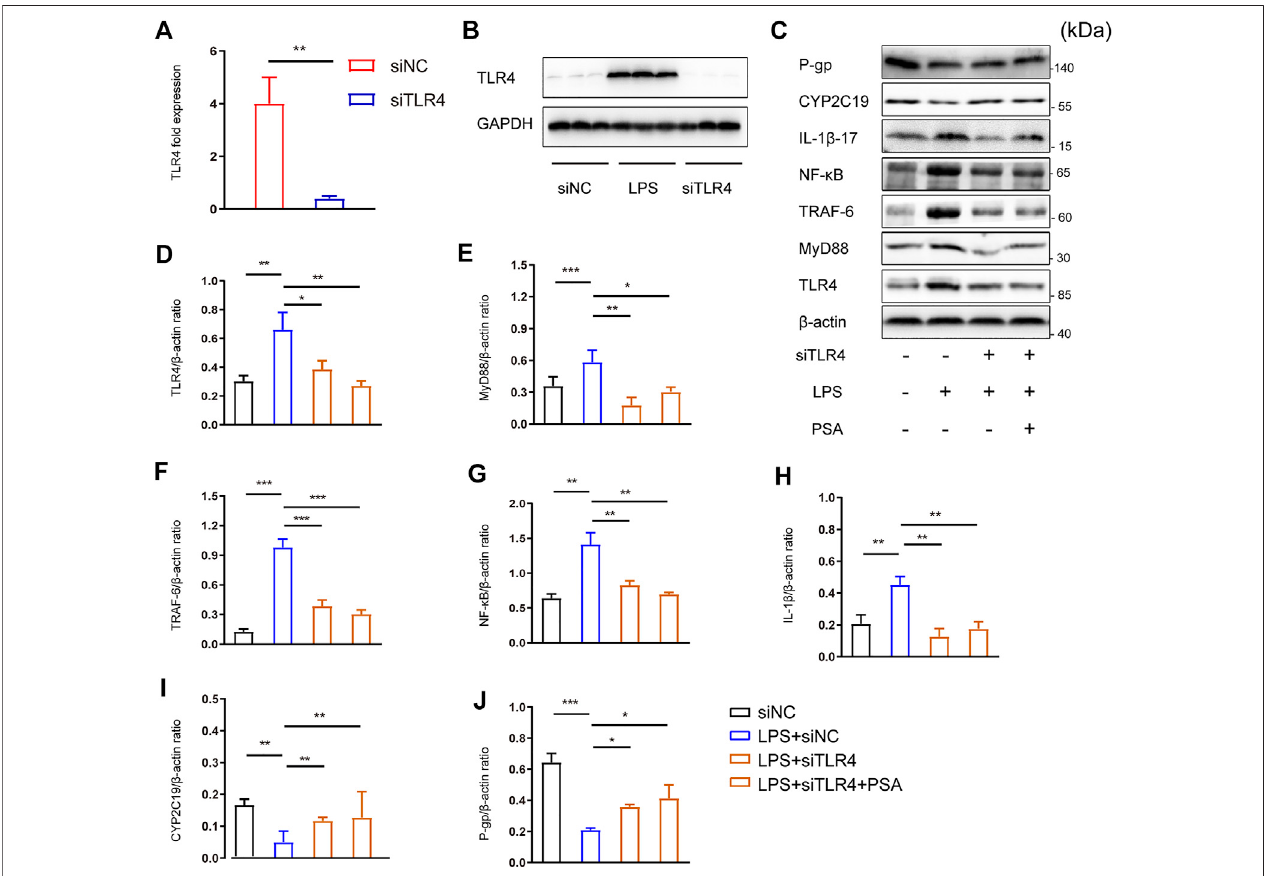
FIGURE 7 | PSA up-regulates the expression of hepatic CYP2C19 and P-gp by inhibiting TLR4/NF- κ B signal pathway. (A,B) RT-PCR and Western blot analyses were used to evaluate the ef fi ciency of TLR4 knock-down by siRNA (** p < 0.01) (C – H) Immunblots (C) and densitometric analysis of TLR4 (D) , MyD88 (E) , TRAF6 (F) , NF- κ B (G) and IL-1 β (H) in primary hepatocytes treated with the vehicle, LPS, LPS + siTLR4 and LPS + PSA (C,I – J) , Immunblots (C) and densitometric analysis of CYP2C19 (I) , and P-gp (J) in primary hepatocytes. Western blot results represent three independent experiments. * p < 0.05, ** p < 0.01, *** p < 0.001, t -test.